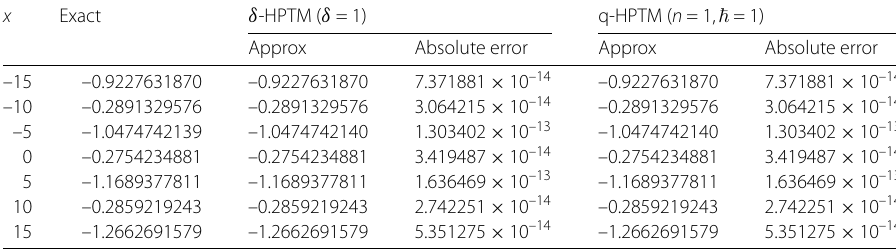
Table 6 The comparative study of Im[ W (3) ] solutions of δ -HPTM, q-HATM, and exact solution